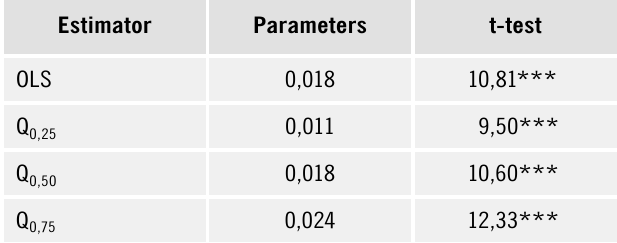
*** indicates statistical significance at the 1% level.